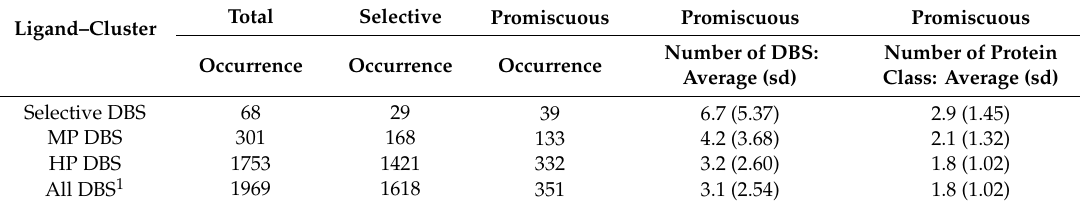
Table 3. Distribution of the Ligand–Clusters relative to their ability to interact with DBS of di ff erent levels of promiscuity (rows). The last row, “All DBS”, indicates the values of all the Ligand–Clusters in the DBS4 dataset. The columns indicate the total number of Ligand–Clusters, and those that interacted with one DBS (selective) or more (promiscuous). For the promiscuous Ligand–Clusters, we detailed the average number of DBS bound and the average number of protein class bound (not indicated for the selective Ligand–Clusters, as they bind to one